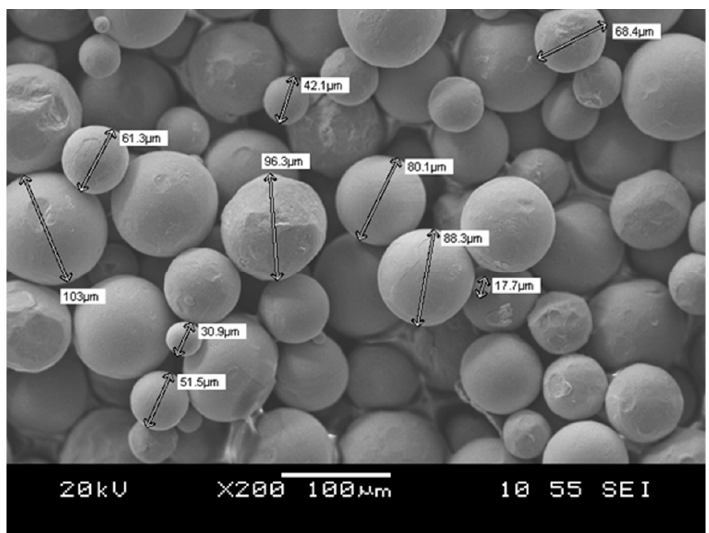
Figure 2. Determination of powder particle size with a scanning electron microscope.